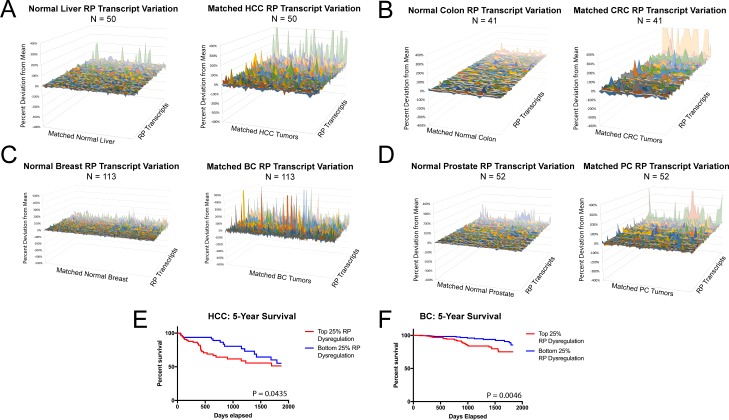
RP transcript deregulation in human cancers.3D area maps of transcript levels for 77 RPs expressed in HCCs (A), CRCs (B), BCs (C) and PCs (D). To better evaluate differences in the other transcripts which did reach significance for their F-tests, these transcripts–Rps26, Rpl9, Rps27, Rps28, and Rpl21– were excluded from 3D area plots. For each cancer, tumors with matched samples of normal tissue in TCGA were selected for direct comparison (50 for HCC, 41 for CRC, 113 for BC and 52 for PC). Relative expression for each RP transcript was calculated as in Fig 1. See Figures D-G in S1 File for 3D area plots of the above matched tumor data together with additional data from unmatched tumor samples. (E, F) Patient survival in HCC and BC inversely correlates with the severity of RP transcript deregulation. Patients were sorted according to their RP transcript deregulation, and survival curves were plotted for the top and bottom 25% of patients with the greatest and least degree of RP transcript deregulation.